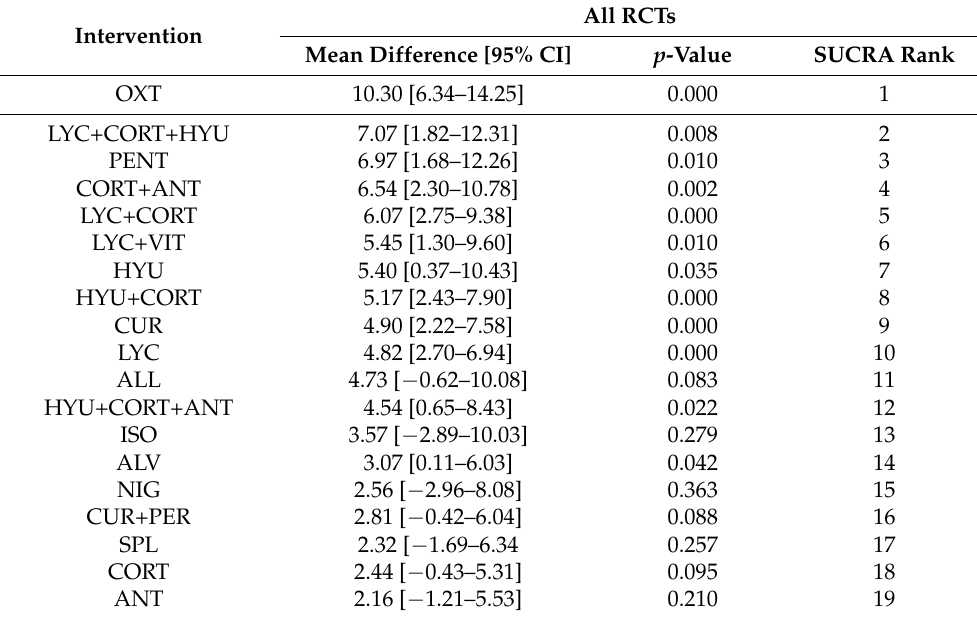
Table 1. SUCRA ranking table for the comparative efficacy of different interventions used in the management of OSMF (mouth opening).